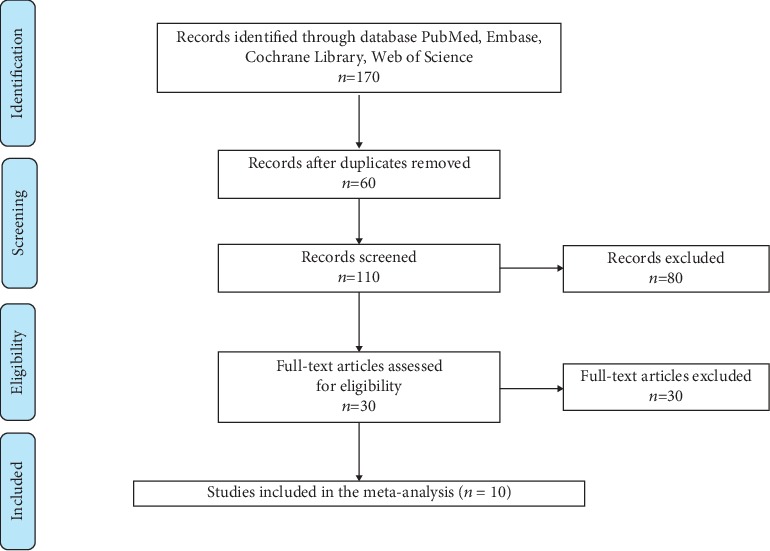
Flow chart of the study selection.